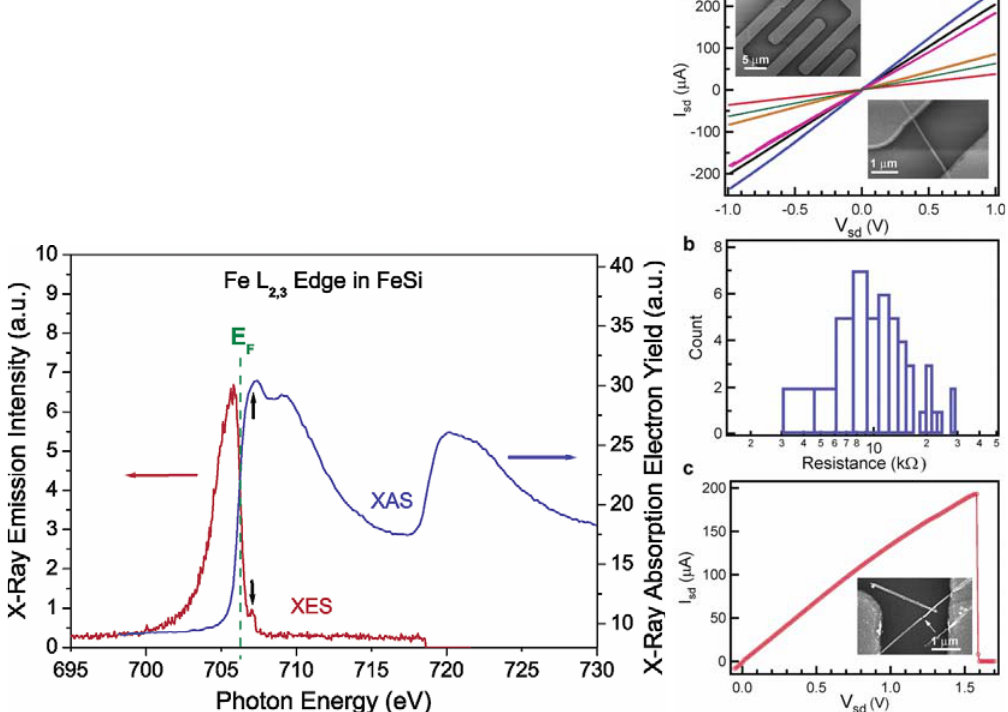
Figure 13. (Left) Spectroscopic characterization of FeSi nanowires by X-ray absorption spectroscopy (XAS) and X-ray emission spectroscopy (XES) at the Fe L arrows point to the excitation energy (top) and the elastic peak (bottom). (Right) Room- temperature transport properties of FeSi NWs in two-terminal devices. (a) I several typical FeSi NW devices. (Insets) SEM images of a typical device. (b) Histogram of observed resistance for 47 single FeSi NW devices. (c) I FeSi NW device that breaks down at higher voltage and current. (Inset) SEM image of this particular device after failure. The arrow highlights the breaking point. Reproduced from Ref. [84] with permission from American Chemical